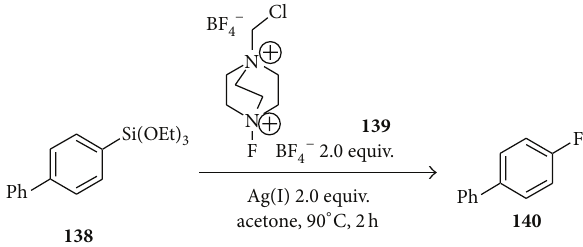
Scheme 33: Silver-mediated synthesis of